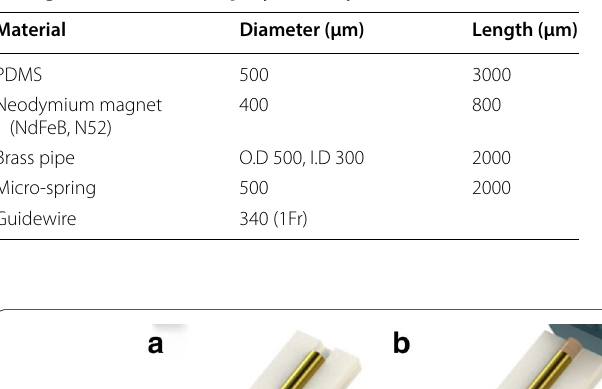
Table 2 Geometric properties of flexible microrobots with guidewires PDMS, polydimethylsiloxane